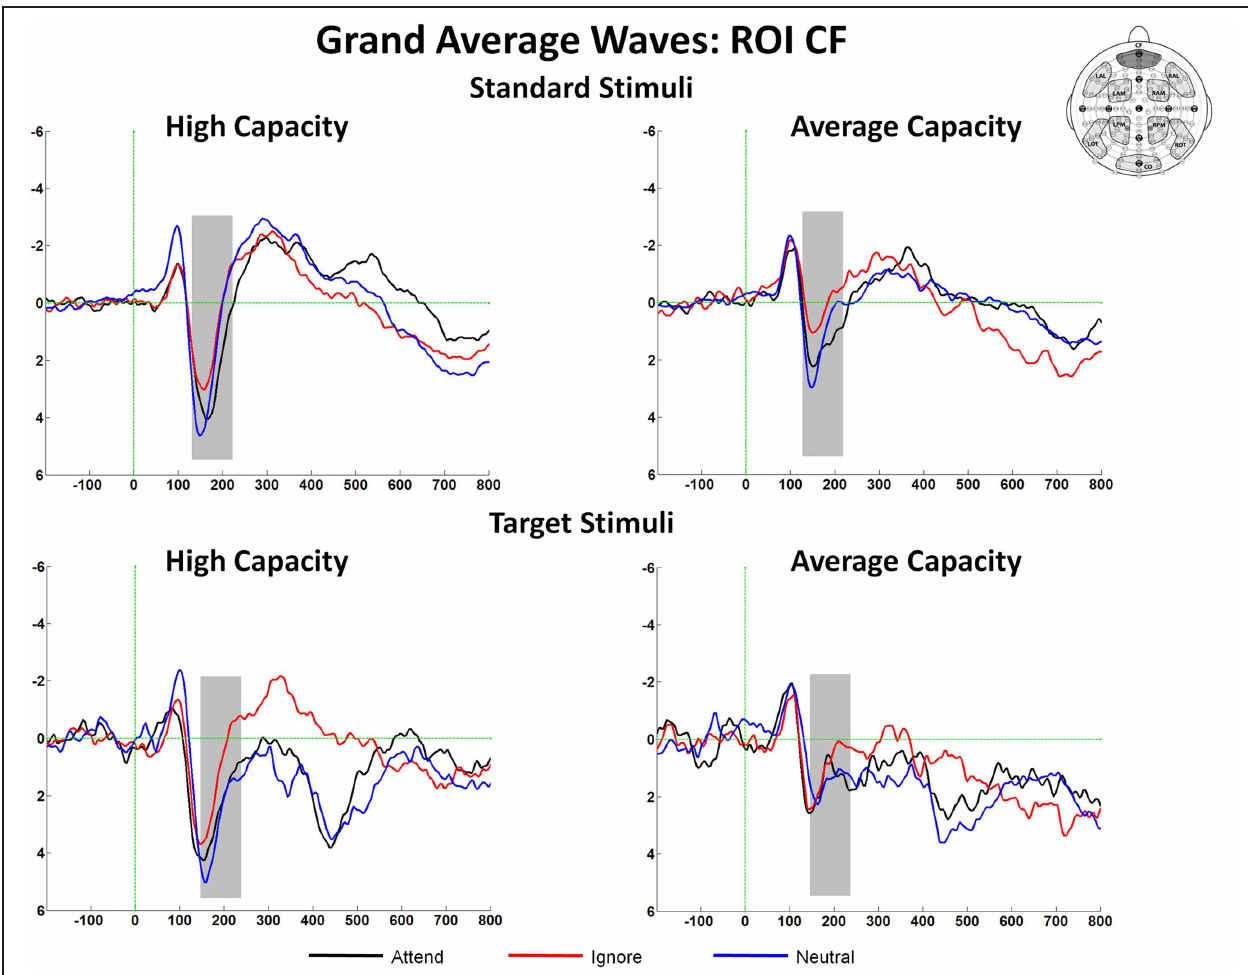
FIGURE 4 | Illustration of the differences between conditions at the anterior ROI, CF for high capacity and average capacity subjects in response to standard stimuli and target stimuli. The highlighted area represents the temporal interval in which the Selection Positivity (SP) was measured.